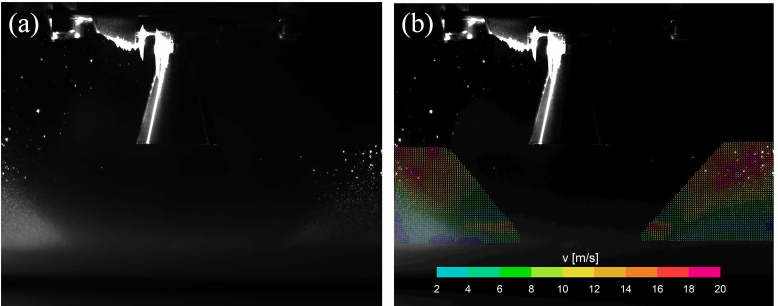
Figure 25. Plume–Lunar regolith interaction test conducted at Beihang University. ( a ) Representative snapshot captured by the particle image velocimetry (PIV). ( b ) The corresponding velocity of ejected particles calculated from